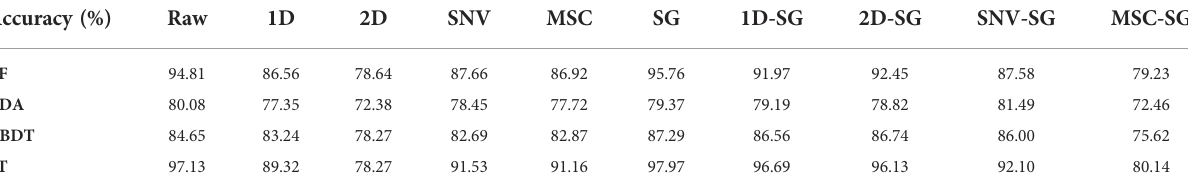
TABLE 1 Accuracy rates of 10 preprocessing methods based on the 4 algorithms. Accuracy